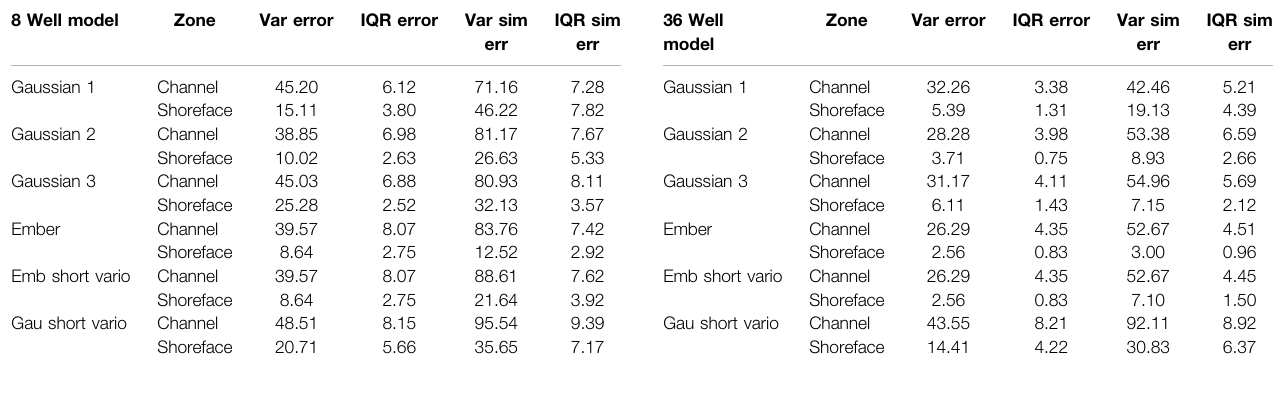
TABLE 1 | Variance of trror and IQR for three Gaussian models and the Ember model,aswellasforthepoorchoiceof “ short ” variogramforbothtypes.Eight- well case: green is the best case, and red is the worst case.